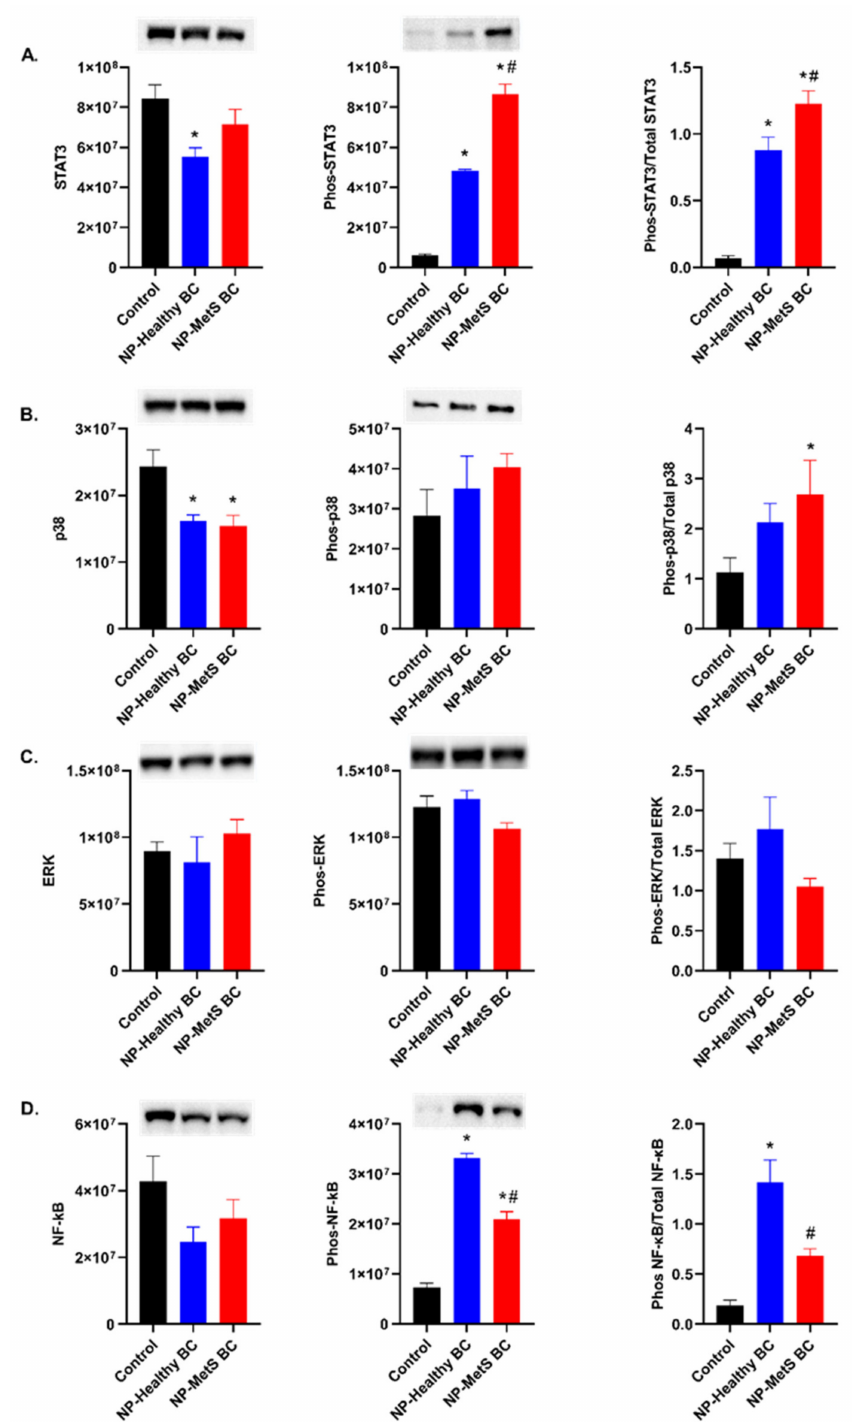
Figure 10. Inflammatory signaling after a 24 h exposure to NPs with MetS or healthy BCs. Changes in protein level following exposure to Fe 3 O 4 NPs with a healthy or MetS BC. Cells were exposed to 25 µ g/mL of Fe 3 O 4 NPs with BCs for 24 h (n = 3/group). Activation of STAT3 ( A ), P38 ( B ), NF- κ B ( C ), and ERK ( D ) pathways were assessed through Western blot to evaluate MetS-related inflammatory signaling pathways following NPs exposures. * Denotes statistical significance compared to the expression of control group, # denotes statistical significance compared to the Fe 3 O 4 NPs with a healthy BC ( p < 0.05). Quantification of each protein was normalized to the intensity of total protein (blots found in Supplementary Materials Figure